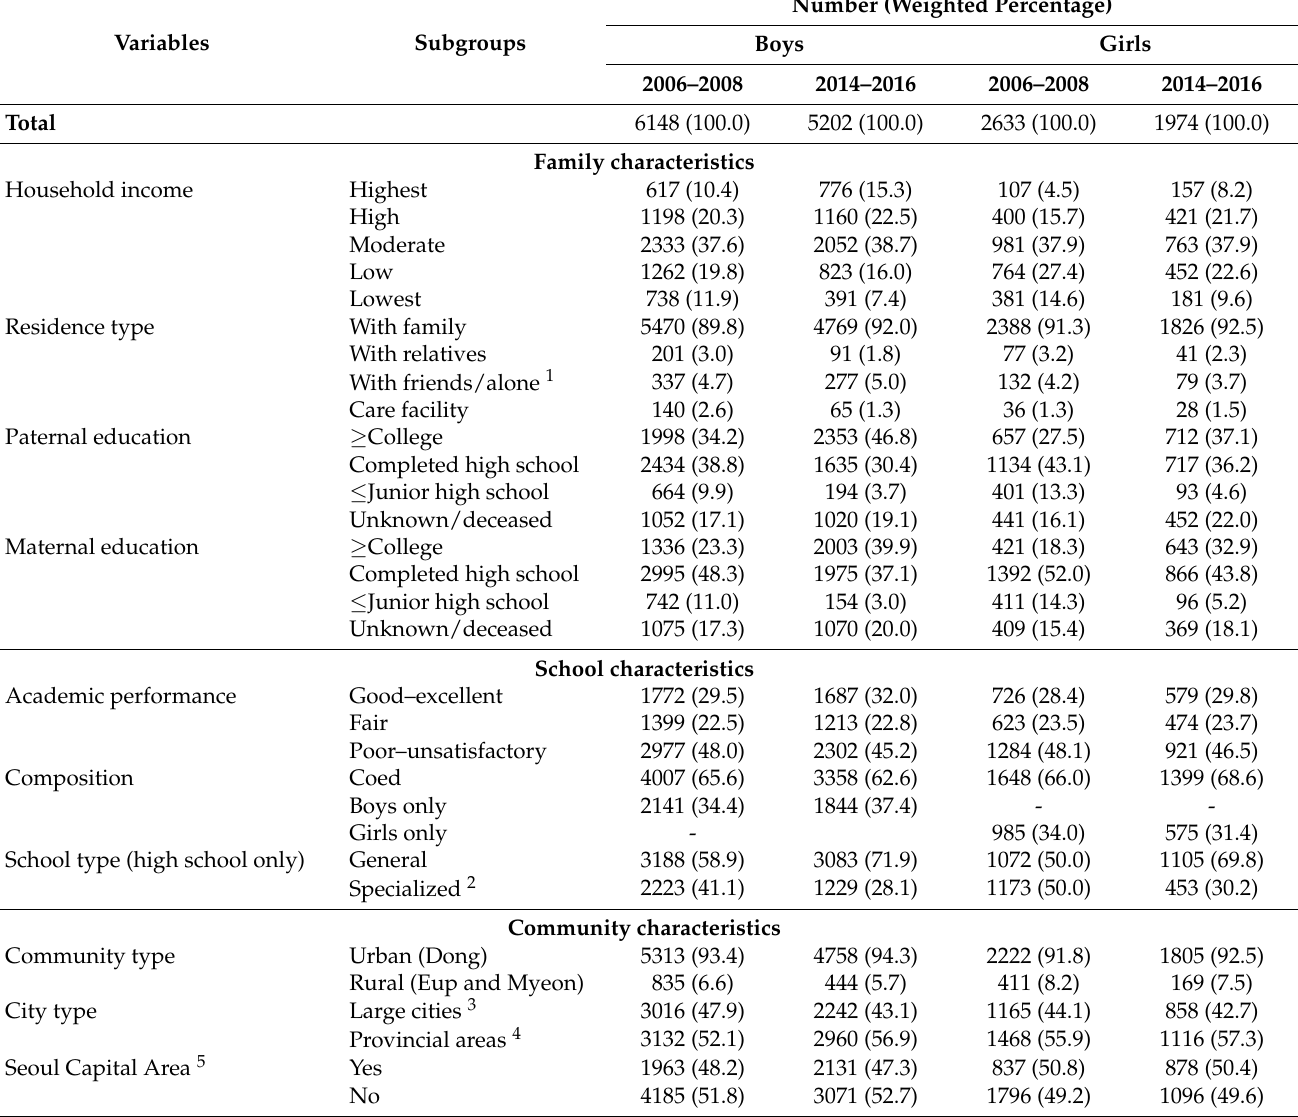
Table 1. Socio-environmental characteristics of students reporting sexual intercourse by